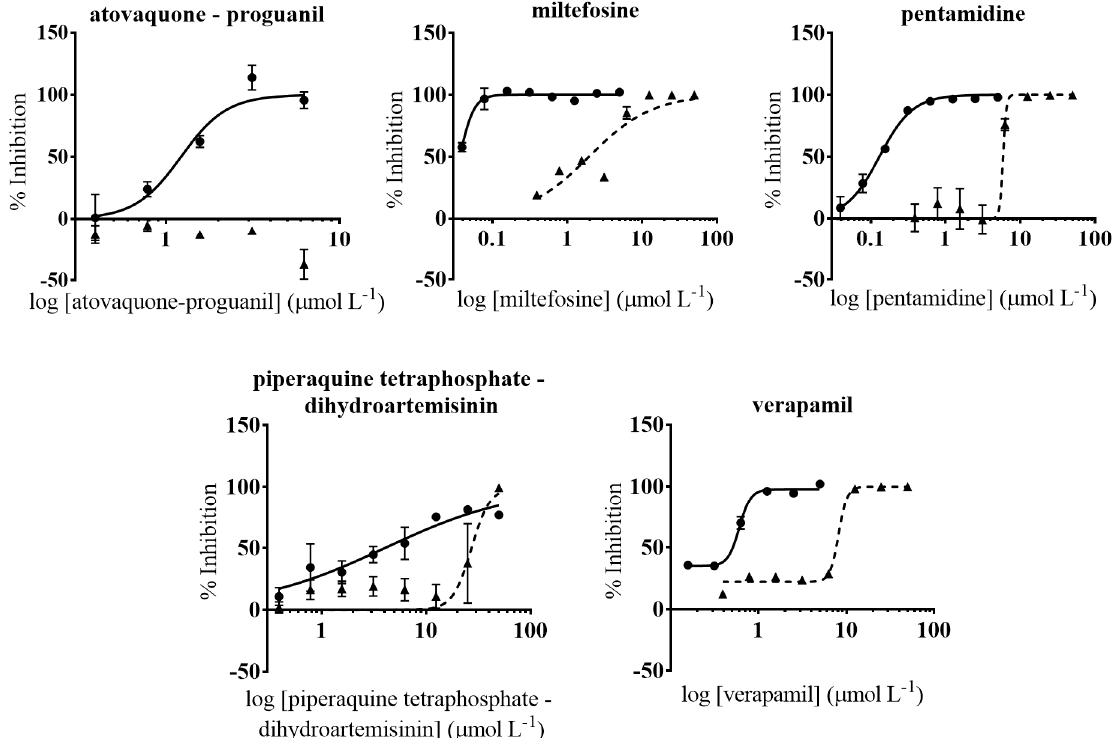
Figure 3. Dose-response curves of anti- T. cruzi and cell toxicity assays based on NIH-3T3 cells. Anti- T. cruzi assay data are represented by circles and straight lines, while NIH-3T3 cells toxicity assay data are represented by triangles and dashed lines. Graphs represent mean values and SD of at least three replicas.